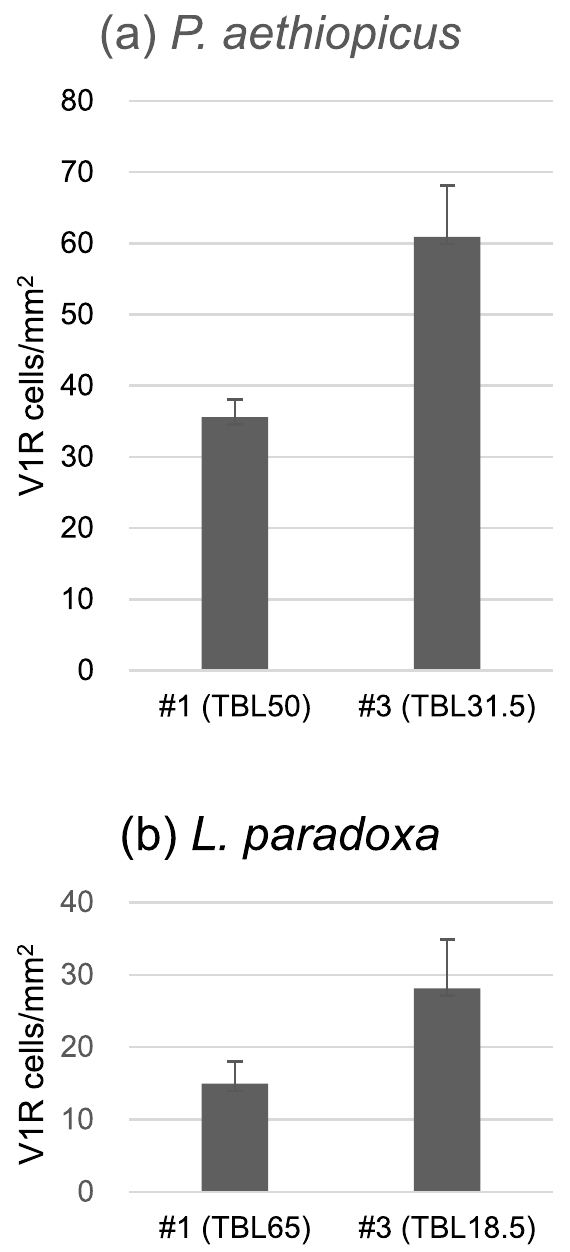
Fig. 7 Comparison of V1R -expressing cell density in the lamellae between adult (#1) and juvenile (#3) of P. aethiopicus ( a ) and L. paradoxa ( b ). Data are shown as mean both lungfish, the density of V1R -expressing cells was higher in